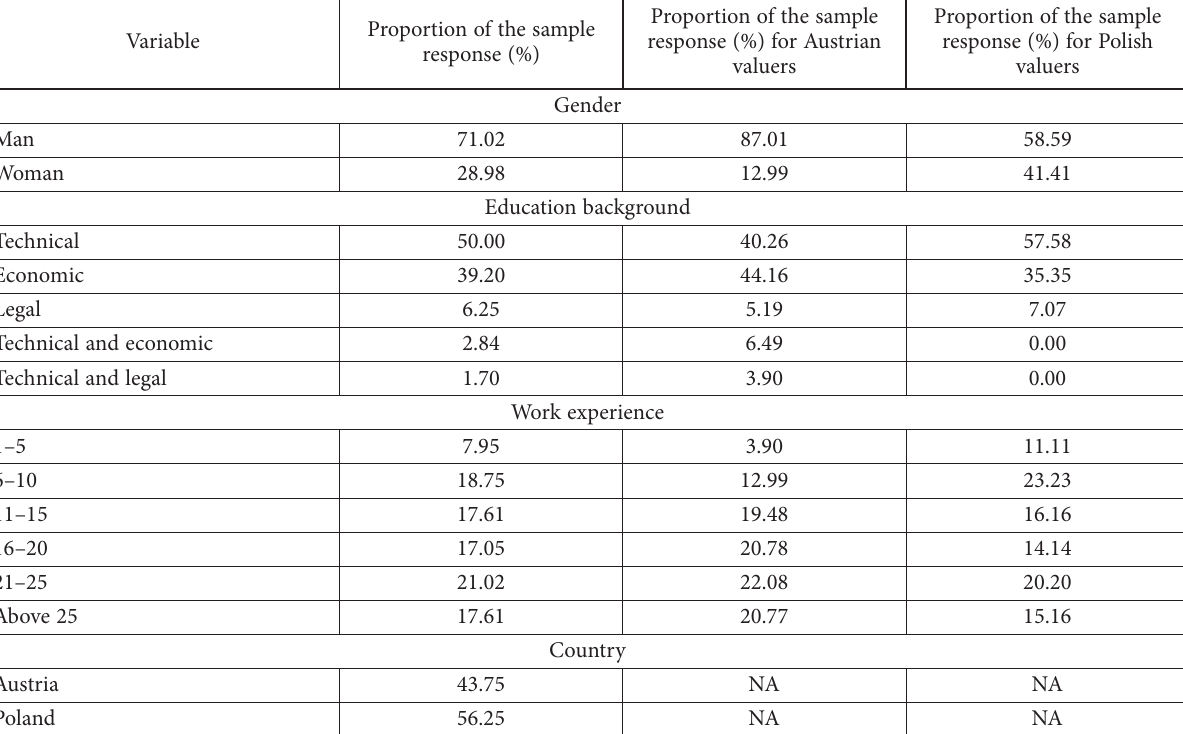
Table 1. Structure of respondents (source: survey